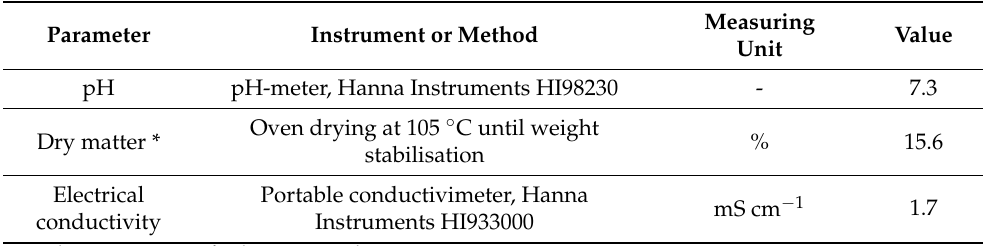
Table 2. Main physico-chemical properties of the raw OP used in the lysimetric tests. Parameter Instrument or